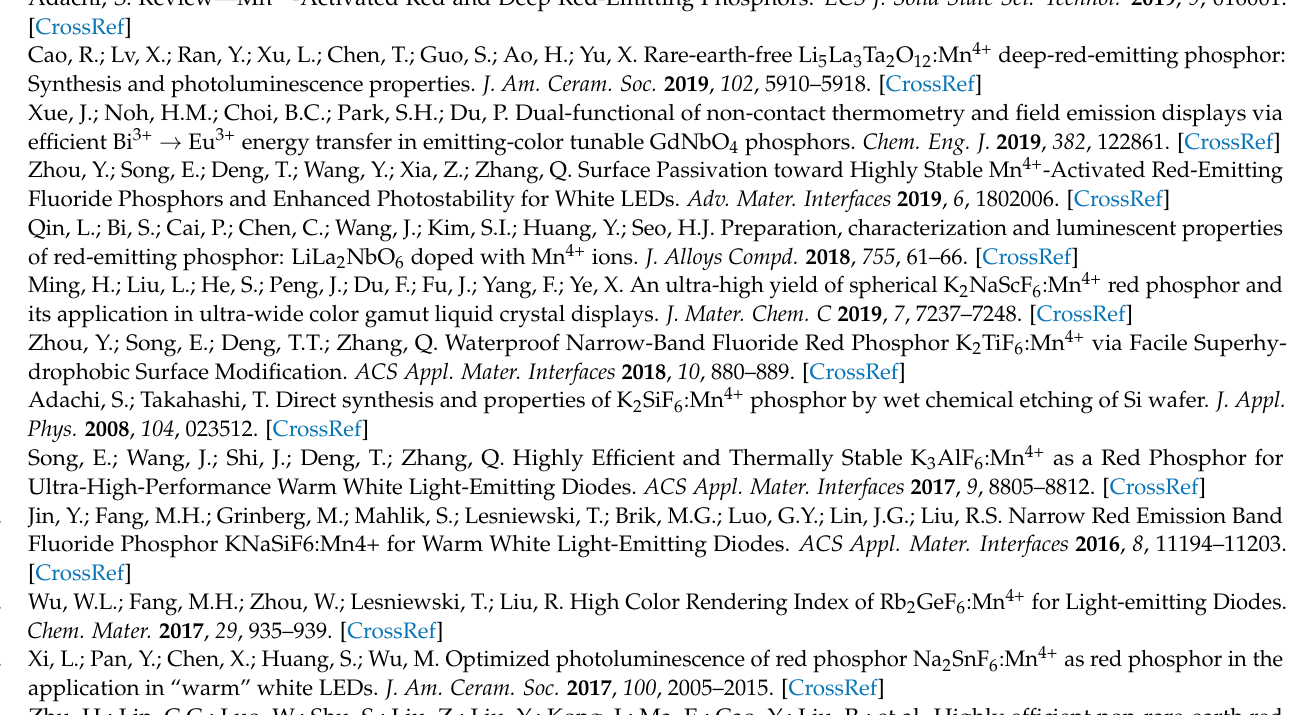
sample. Figure S2. The fitting of temperature-dependent decay curves. The decay curves are recorded by monitoring at 630 nm with excitation at (a) 13 K, (b) 50 K, (c) 100 K, (d) 150 K, (e) 200 K, (f) 250 K, and (g) 295